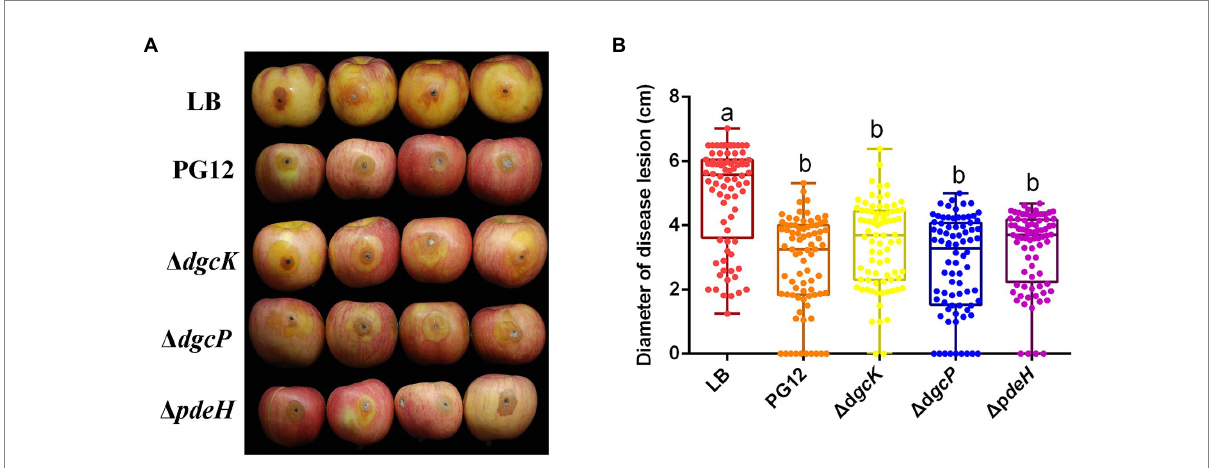
FIGURE 1 Single deletion of diguanylate cyclase or phosphodiesterase encoding gene does not affect the biocontrol efficacy of B. velezensis against apple ring rot disease. Bacteria were incubated for 48 h in LB broth. Biocontrol efficacy was assessed with Fuji apple fruits treated with the 48-h cultures of B. velezensis PG12 (PG12), Δ dgcK , Δ dgcP or Δ pdeH . Apple fruits soaked with the LB broth (LB) were used as controls. Images were taken (A) and the diameter of disease lesions (B) was measured 8 days post inoculation. Values correspond to the mean diameter of 80 disease